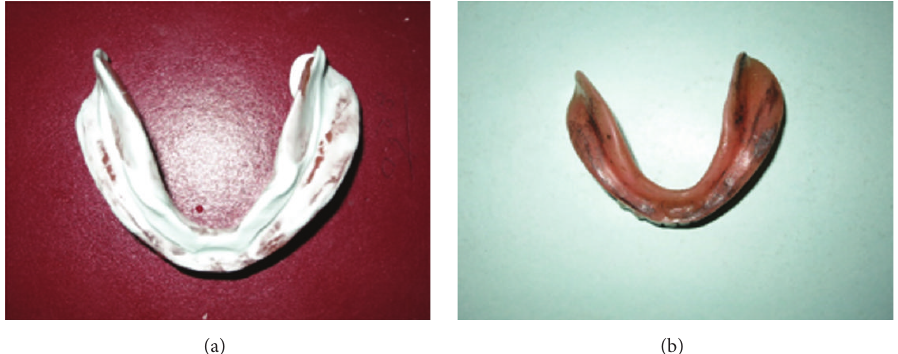
Figure 7: Pressure areas detected with pressure indicating paste and marked with pencil.